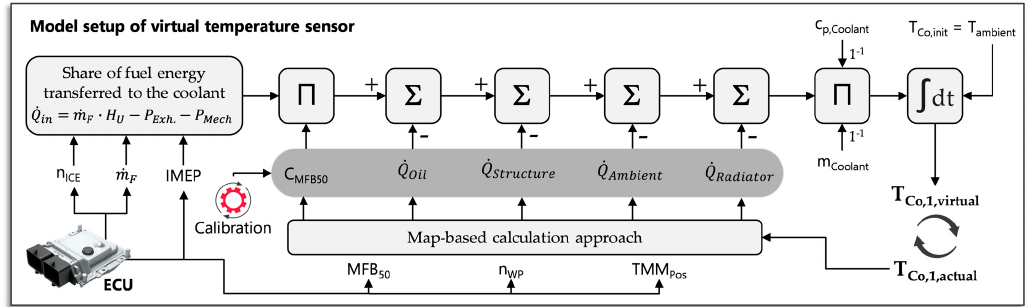
Figure 15. Model setup of virtual coolant temperature sensor T 1 .